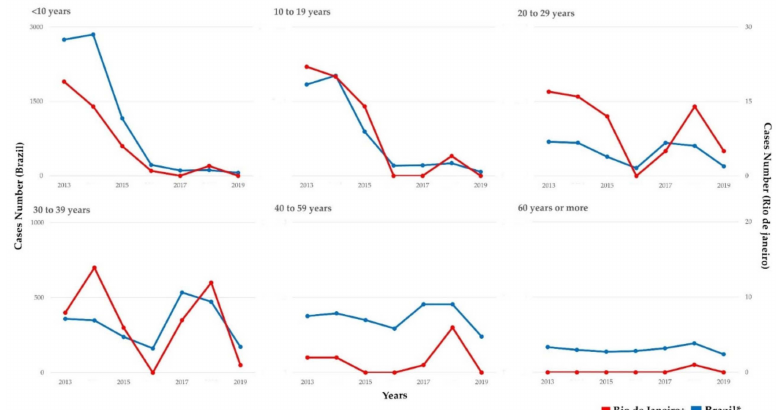
Figure 2. Distribution of HAV cases by years and age groups (2013–2019) in Brazil and the Viral Hepatitis Clinic/Rio de Janeiro. The red line represents the HAV cases registered in Brazil, and the blue line represents the cases registered in the Clinic. * Data kindly provided by the General Coordination of Strategic Information, Department of Chronic Conditions and Sexually Transmitted Infections, Secretariat of Health Surveillance, Ministry of Health of Brazil (can be found in the Boletim Epidemiologico Brasileiro [27]. + Viral Hepatitis Laboratory/Ambulatory, Instituto Oswaldo Cruz, Oswaldo Cruz Foundation, Ministry of Health, Rio de